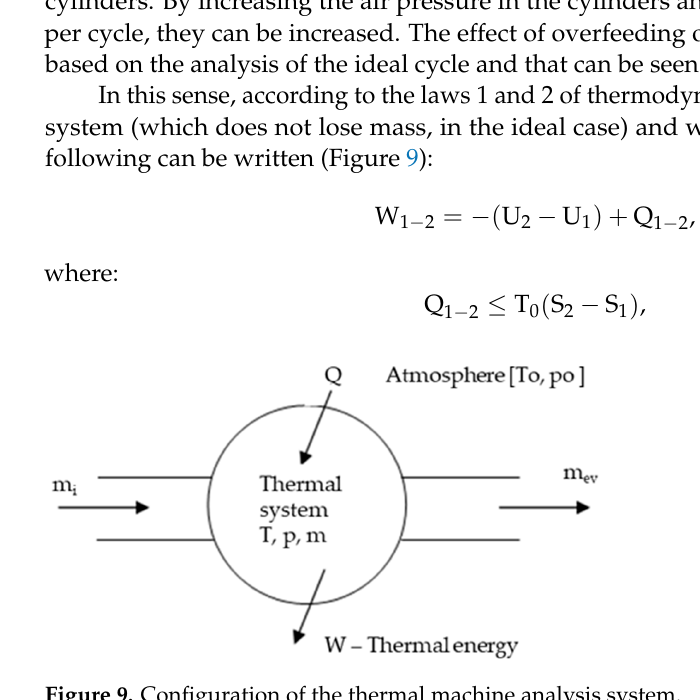
Figure 9. Configuration of the thermal machine analysis system.